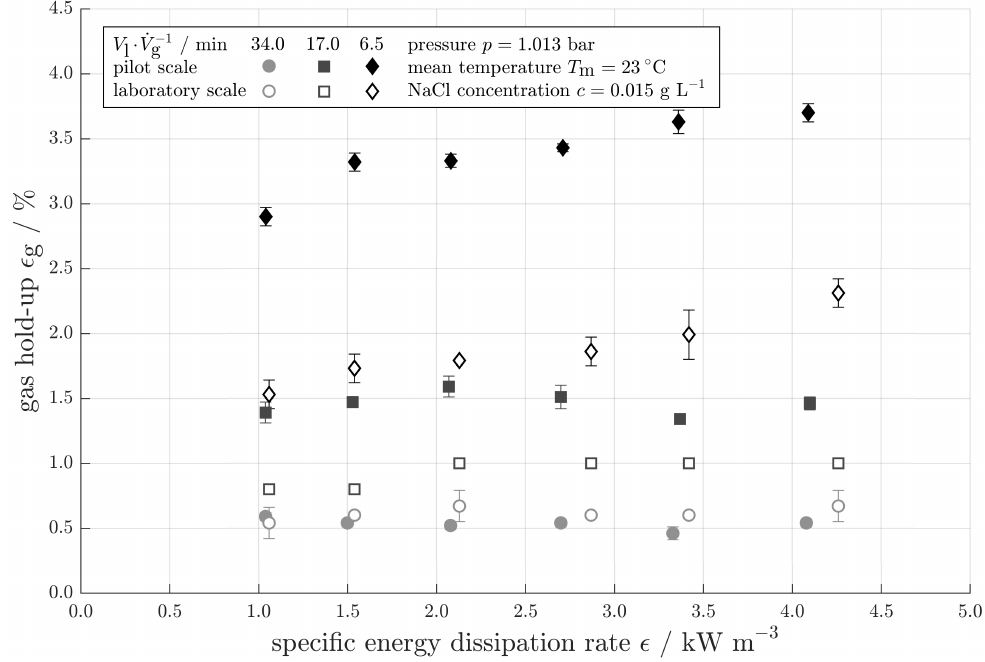
Figure 6. Gas hold-up (cid:101) g in relation to the specific energy dissipation rate (cid:101) in both the pilot- and laboratory-scale